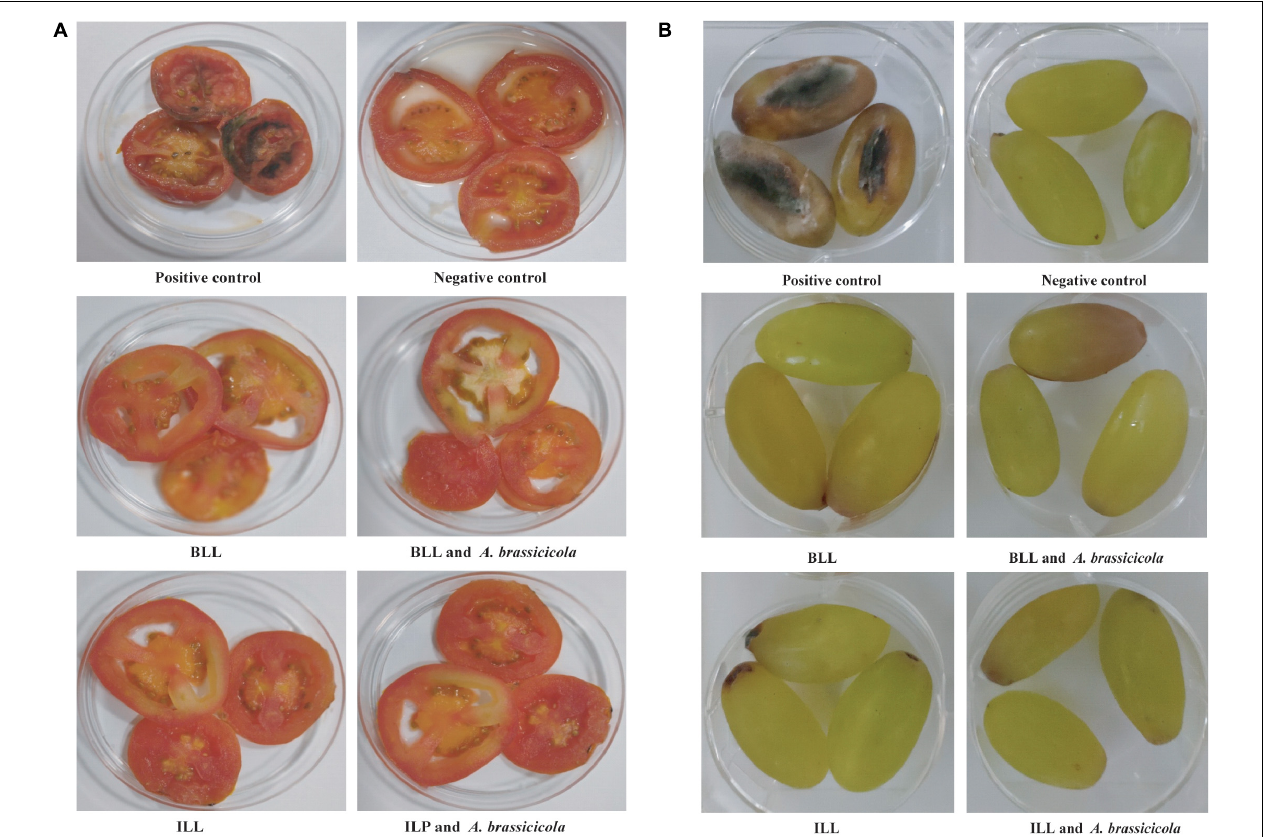
FIGURE 6 | Protective ability of lipopeptides against infection of A. brassicicola MTCC 2102 in in vitro assay. (A) Inhibition of A. brassicicola MTCC 2102 on sliced tomato. (B) Inhibition of A. brassicicola MTCC 2102 on